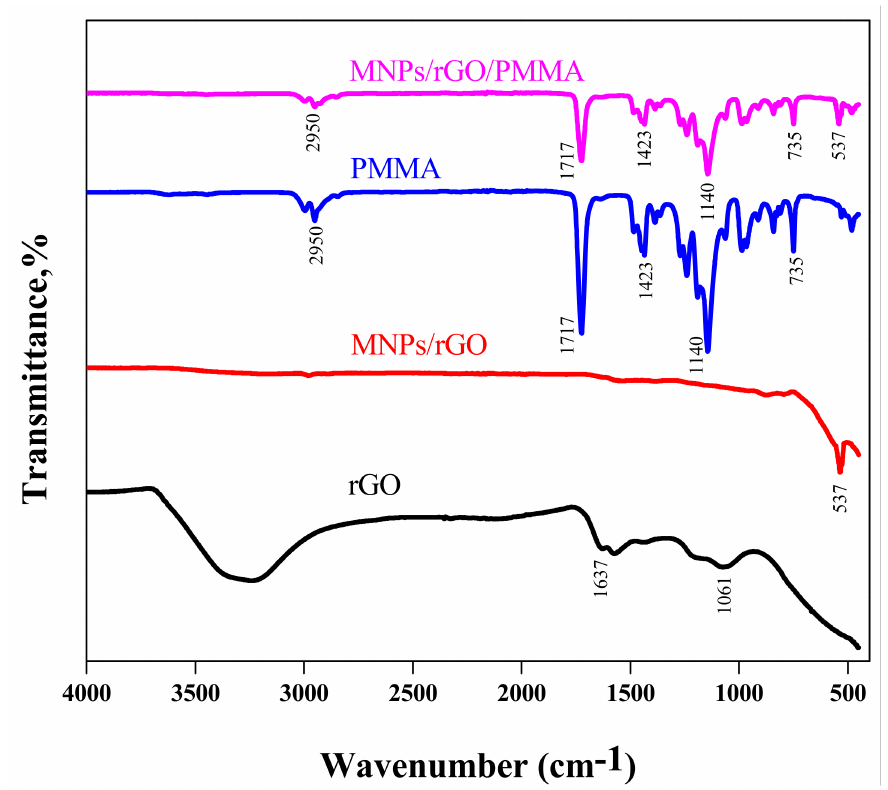
Figure 1. FTIR spectra of rGO, Fe 3 O 4 /rGO, PMMA and